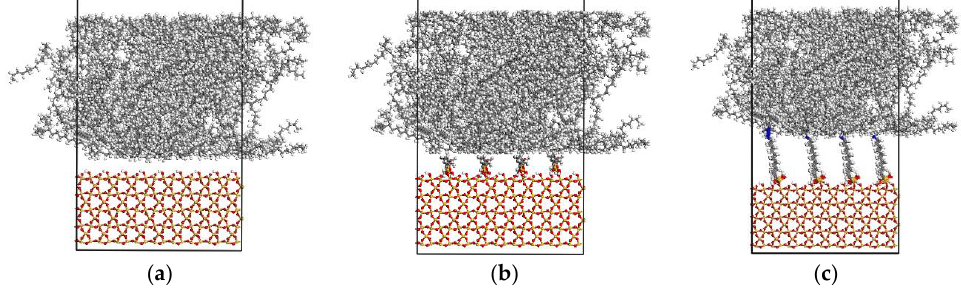
Figure 5. The molecular model of ( a ) PE(76 – 40)/S; ( b ) PE(76 – 40)/mS1; and, ( c ) PE(76 – 40)/mS2.